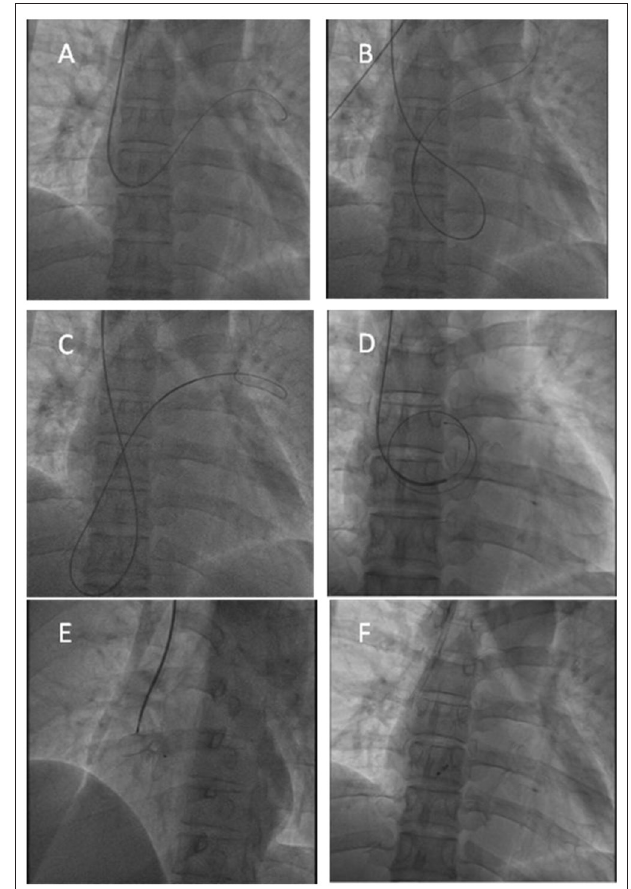
FIGURE 4 | Transcatheter PFO closure procedure. (A,B) The guidwire reached the left superior pulmonary vein through the PFO; (C,D) The ordinary guidewire could not provide sufficient support, and a 180cm 0.025” stainless steel guidewire with coiled floppy tip was exchanged to provide sufficient support; (E) X-ray showed good position before the occluder was released; (F) X-ray showed good position after the occluder was